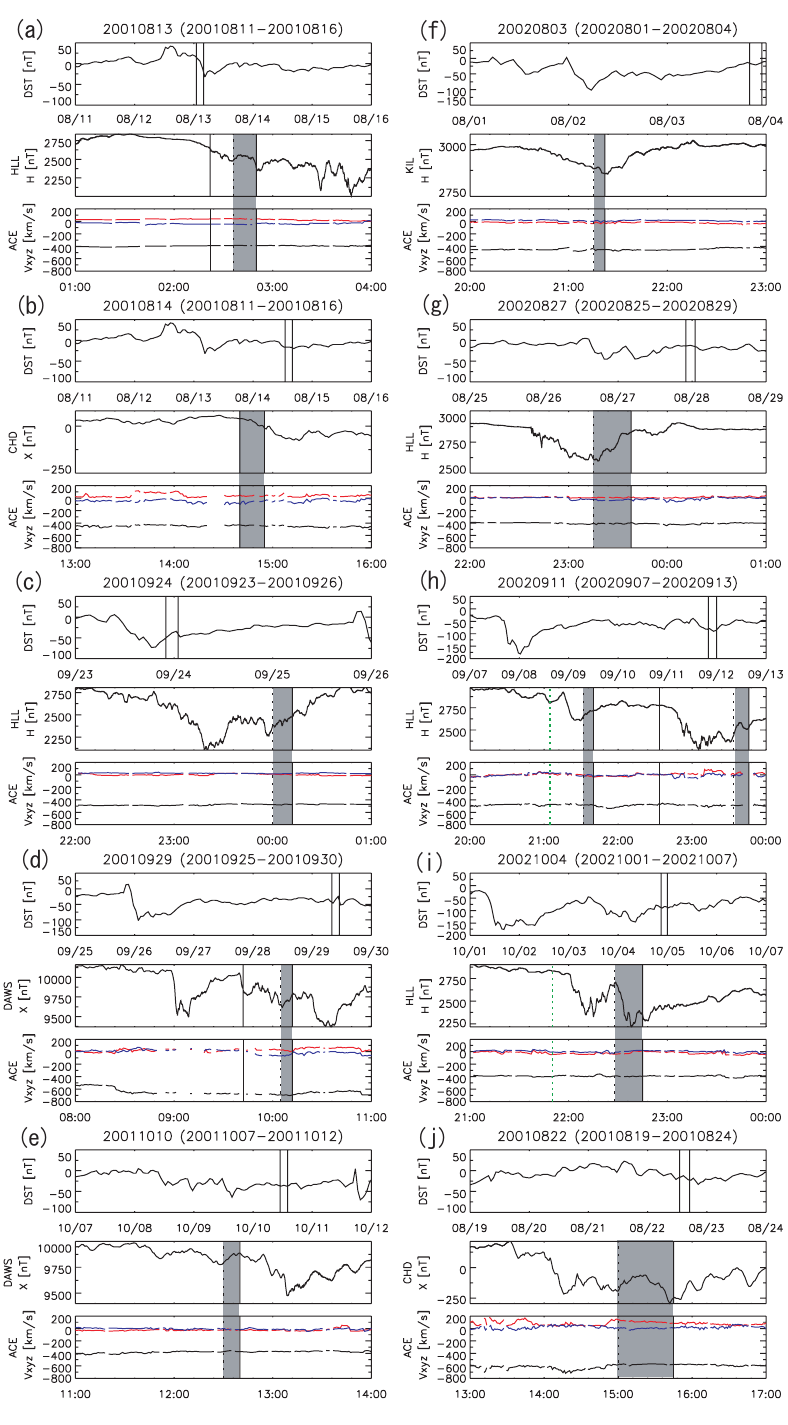
Fig. 7. Stack plots of D st , H or X component from ground magnetometers, time-shifted solar wind velocity (ACE). Two vertical lines in Dst show the time interval of ground and solar wind data ( Vx : black, Vy : red, Vz : blue). The vertical lines in ground and solar wind data mark the appearance of lobe fluctuations (black dashed) and PS-lobe boundary crossings (solid). For comparison, green dashed lines mark the time of non-selected fluctuation events. Selected event intervals are gray-shaded. Positions of ground stations are following: Hella/Island (HLL: CGMlat. 64.37, CGMlon. 67.60), Kilpisj¨arvi/Finland (KIL: CGMlat. 65.90, CGMlon. 103.93), Chokurdakh/Russia (CHD: CGMlat. 64.67, CGMlon. 212.12), and Dawson/Canada (DAWS: CGMlat. 65.92, CGMlon.